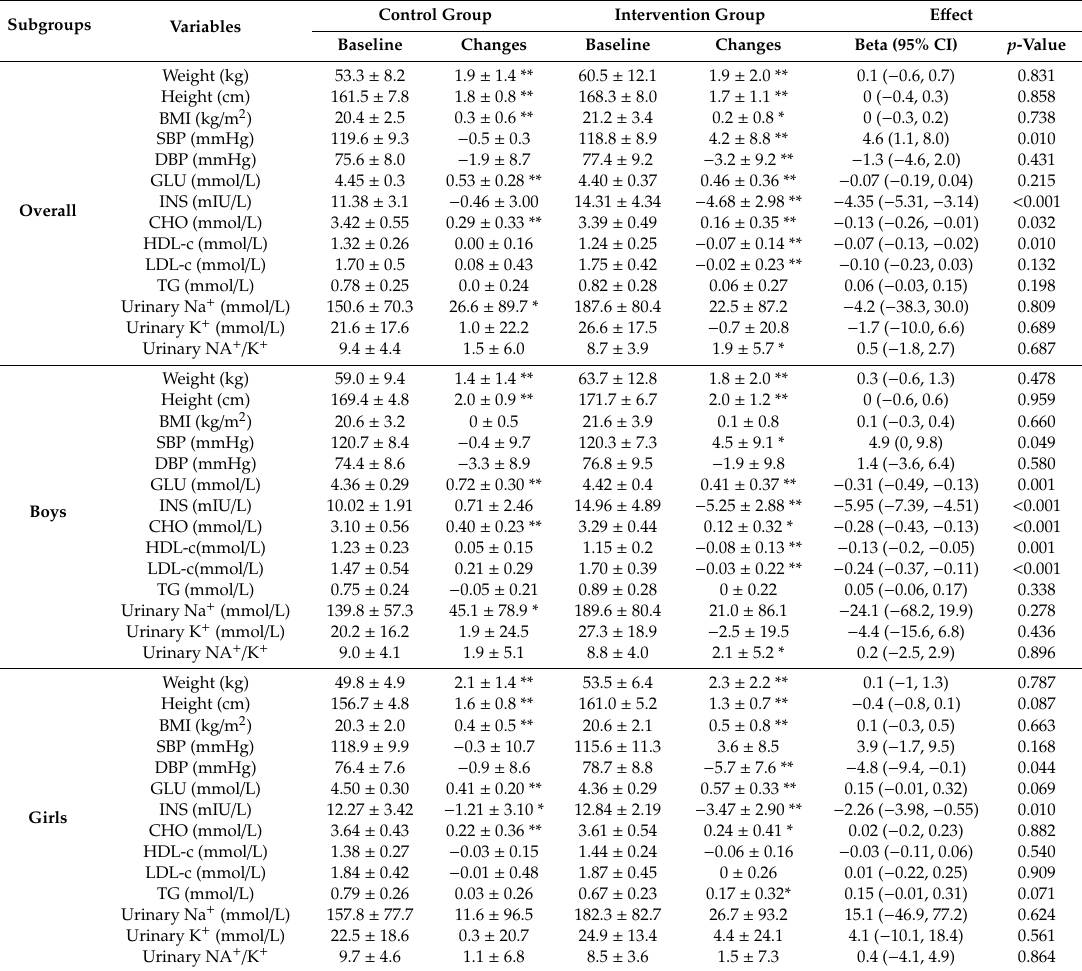
Table 4. Outcomes of the intervention for groups and